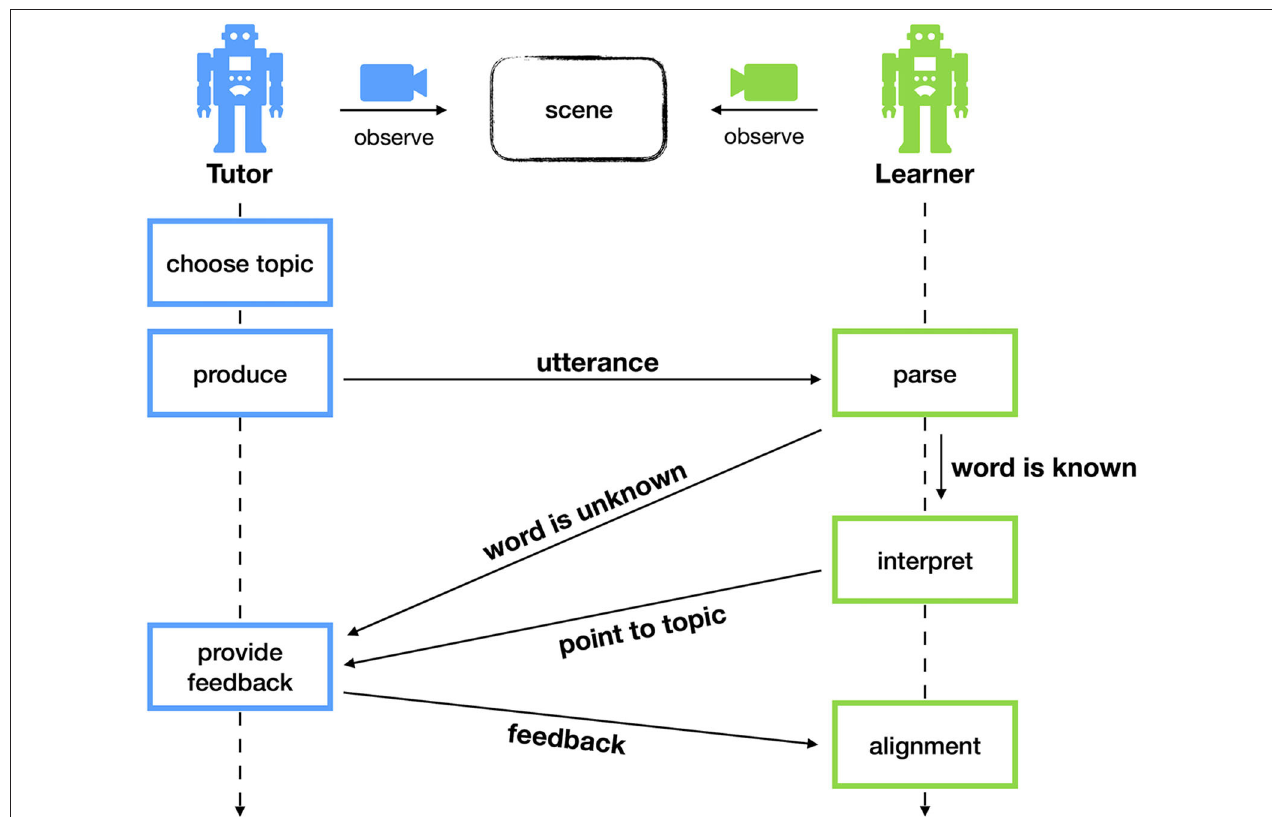
FIGURE 2 | During a single interaction, both agents observe a scene of geometric shapes. The tutor chooses a topic and produces a word denoting a concept that discriminates this topic. The learner looks up this word in his repertoire. If the word is known, the learner tries to interpret this in the scene. Otherwise, the learner indicates failure. After the interaction, the tutor provides feedback to the learner, allowing it to learn.